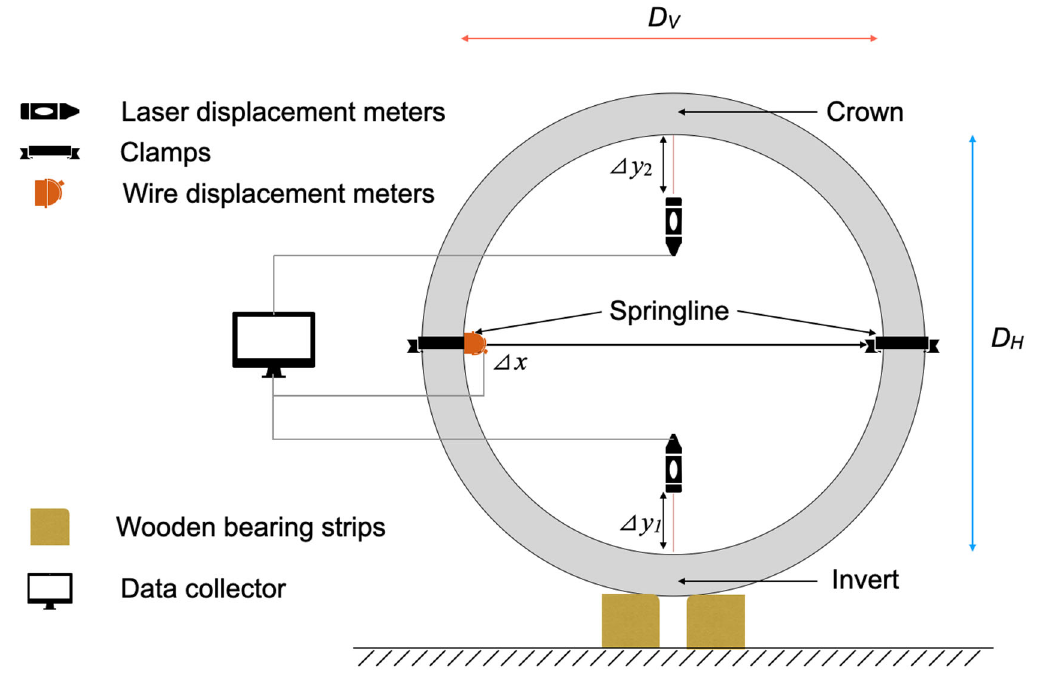
Figure 6. Schematic of the laser displacement measurement installation position.